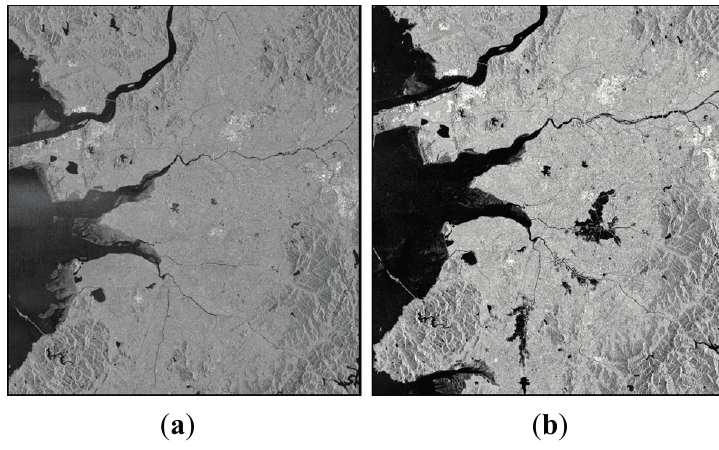
Figure 2. RADARSAT-1 SAR images acquired over the study site area: ( a ) Not flooded; ( b ) Flooded.